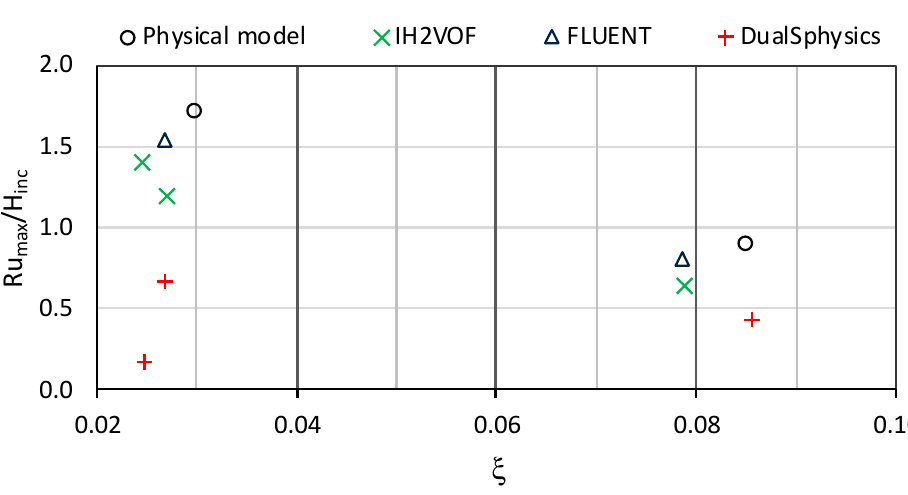
Table 13. Mean wave overtopping discharge calculated by physical and numerical models.